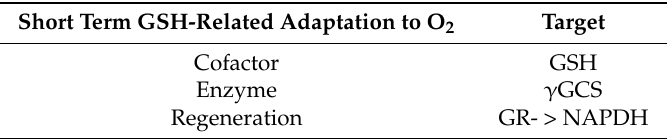
Table 1. Theshorttermadaptivemechanisms. GSH=glutathione; O 2 =oxygen; γ GCS= γ